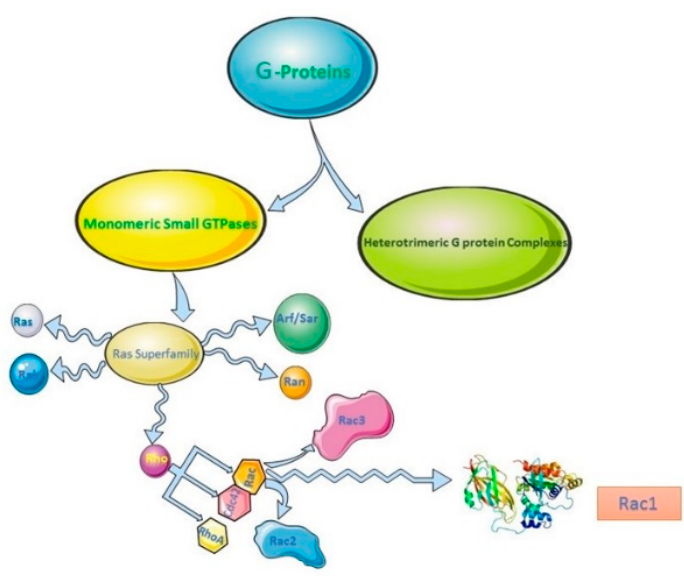
Figure 1. The diagram to illustrate the composition of Ras